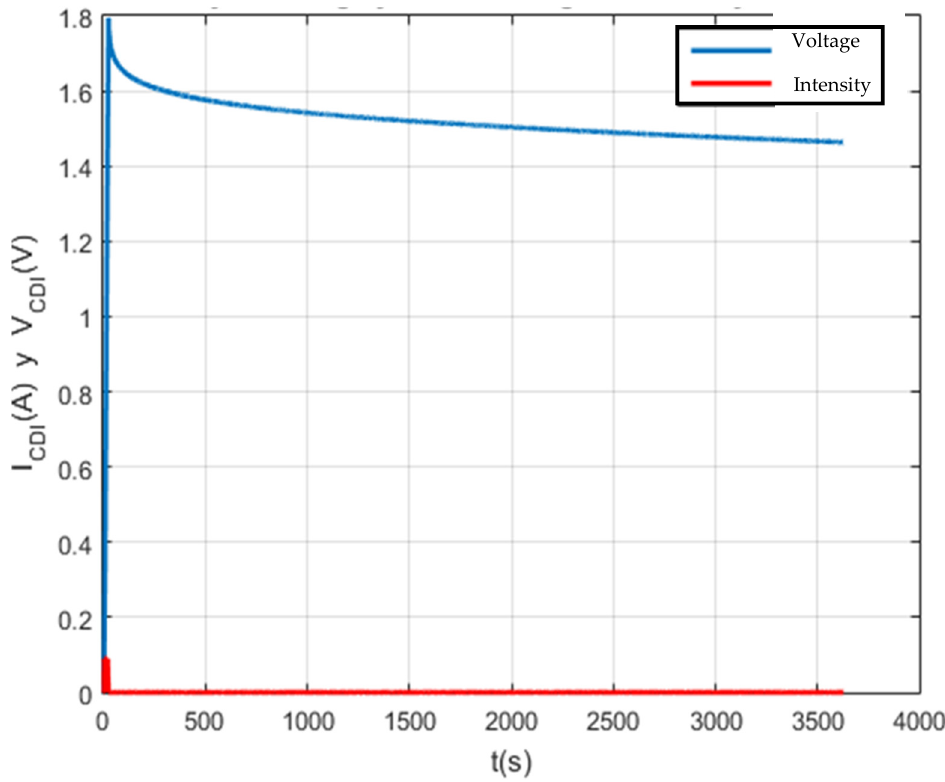
Membranes 2021 , 11 , x FOR PEER REVIEW Figure 14. Self-discharge test to characterize a 1 F capacitor. Figure 14. Self-discharge test to characterize a 1 F capacitor.